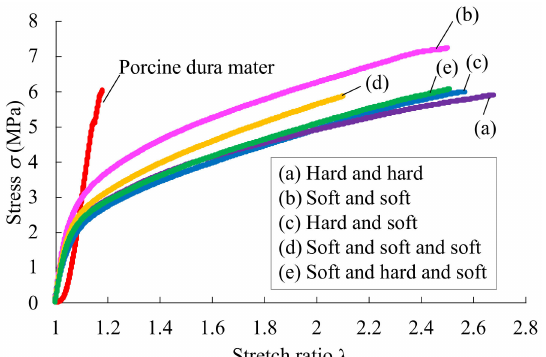
Figure 8. Experimental results of the tensile test in tested dura-matter models.